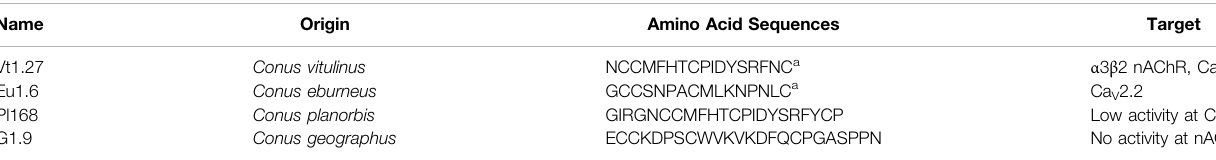
TABLE 2 | Amino acid sequences of Vt1.27 and other α -conotoxins.